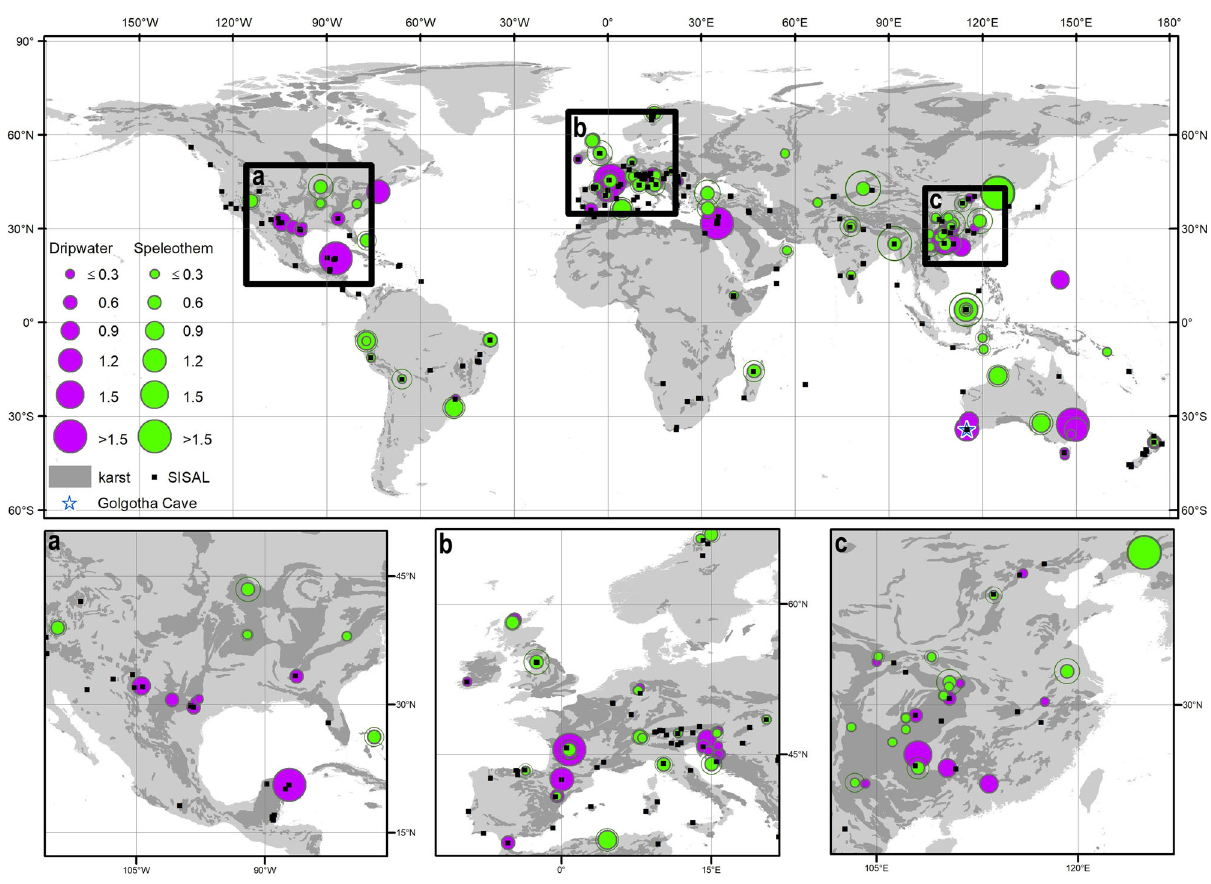
Fig. 1 Locations of caves and mean differences used in global meta-analysis of dripwater and speleothem datasets. The range of mean dripwater δ 18 O values (purple) and the difference between mean values of coeval speleothem records ( Δδ 18 O means ) (green) are indicated by symbol size for each cave. For caves with more than one set of coeval speleothem records the fi lled circle is the average value and the open circle is the maximum value of Δδ 18 O means . Location of Golgotha Cave and other sites from the SISALv2 database are also shown. Darker grey shading indicates karst regions